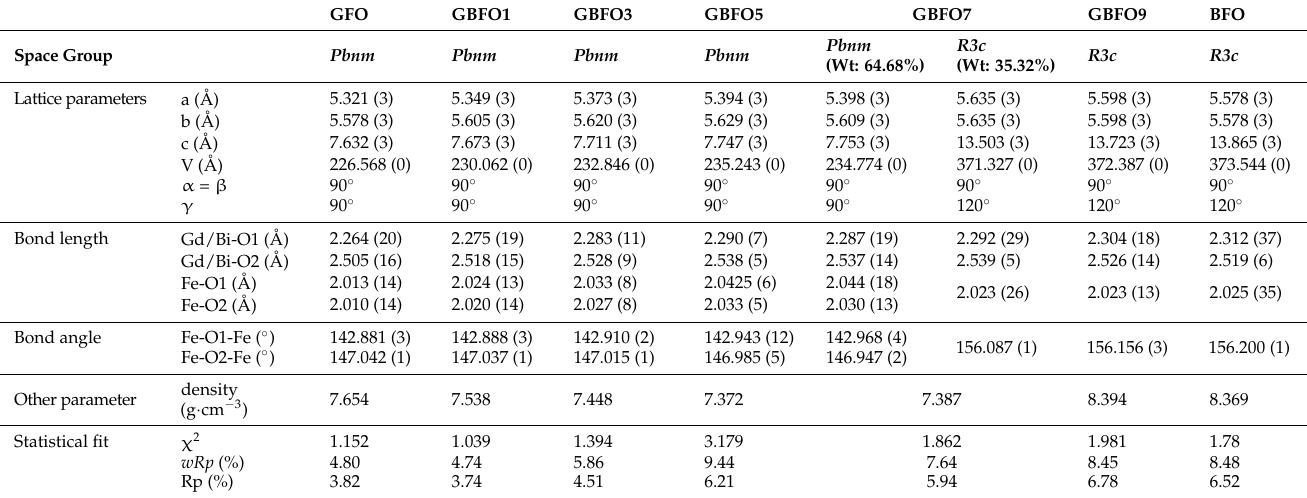
x Bi x FeO 3 (x = 0, 0.1, 0.3, 0.5, 0.7, 0.9, 1.0) −